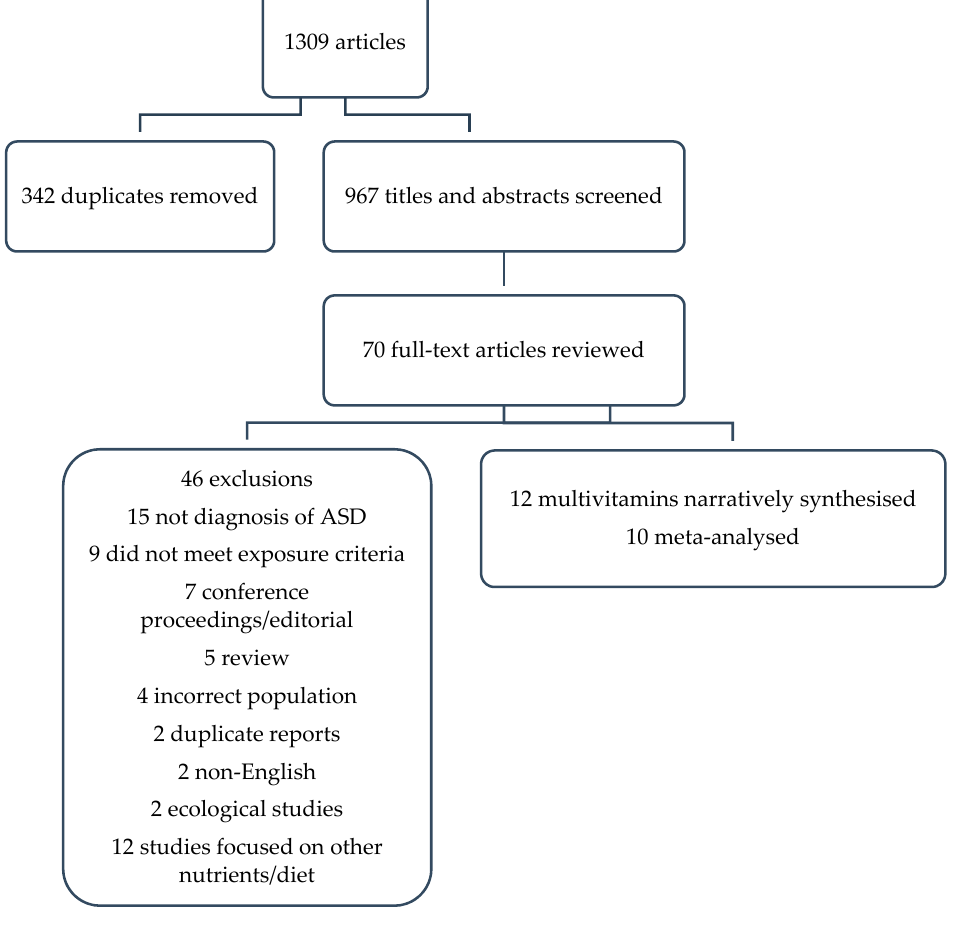
Figure 1. PRISMA flow chart of study selection.